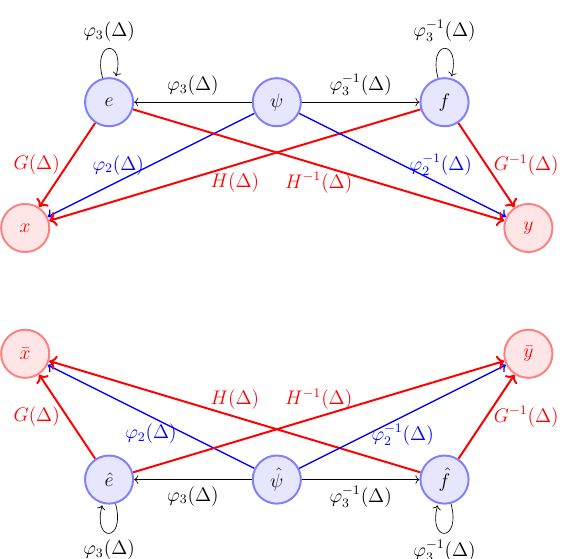
Figure 4 . The OPE relations of the unhatted (cid:12)elds with x and y , and those of the hatted (cid:12)elds with (cid:22) x and (cid:22) y .